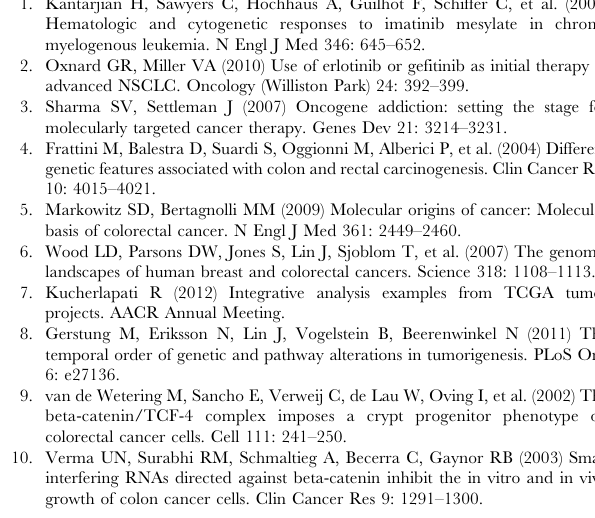
Figure S2 Sequence of the N-terminal b-catenin region in DLD-1 and Ls174T cells. The known CK1 a and GSK3 b target aminoacids 33, 37, 41 and 45 are indicated. Mutation of Ser45 to Phe is confirmed in Ls174T cells. (TIF) Figure S3 Effects of PKF115-584/PLX-4032 combina- tion in HT-29 cells. ( A ) The cells were cultured for 6 days in the presence of inhibitors as single agents or in combination (PKF = 0.5 m M; PLX = 2 m M). Percent growth was evaluated by MTS assay. ( B ) Combination Index values were calculated by CalcuSyn. (TIF) Figure S4 Synergistic effects of pyrvinium/FTS combi- nation in LoVo, SW837 and Colo-201 cell lines. The cells were cultured for 6 days in the presence of inhibitors and then assayed by MTS as described in figure 2. Fractional effect graphs confirm synergism in KRAS-mutated cell lines LoVo and SW837 but not in BRAF-mutated Colo-201. (TIF) Figure S5 Summary of Combination Index values at ED50 for the pyrvinium/FTS combination. BRAF-mutated cell lines are shown in purple. (TIF) Figure S6 Characterization of synergism in DLD-1 cells. ( A ) Cells were treated with 100 m M FTS, 125 nM PKF115-584 or 50 nM pyrvinium, alone or in combinations, or vehicle, for 7 days. Cell culture viability relative to control was assessed by MTS. ( B ) Apoptosis was determined by annexin V/ propidium iodide double staining after 72 hours treatment as indicated. ( C ) c-myc expression evaluated by real-time PCR after 24 hours incubation with the indicated compounds, using GAPDH as a reference gene. Expression was normalized on vehicle-treated control cells. ( D ) The cells were incubated for 72 hours with inhibitors and cell lysates probed with anti-survivin and b -actin antibodies. ( E–F ) Ten thousand cells were grown in soft-agar in the presence of PKF115-584 (0.25 m M), pyrvinium (25 nM), FTS (100 m M), alone or combined. Large colonies were counted 20 days later. The number of colonies formed by untreated control cells is set as 100% ( E ). Representative photographs are shown in panel F . (TIF)